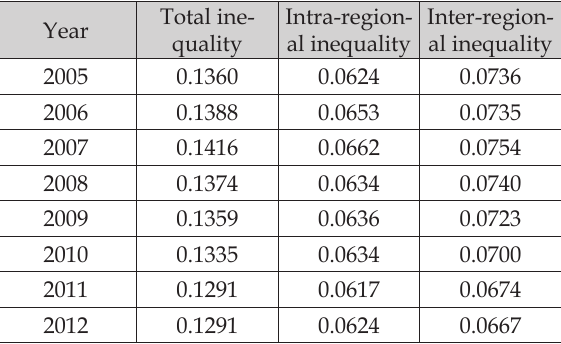
Table 4. Entropy measure of inequality on the basis of per capita income I (x), Poland, 2005–2012 C